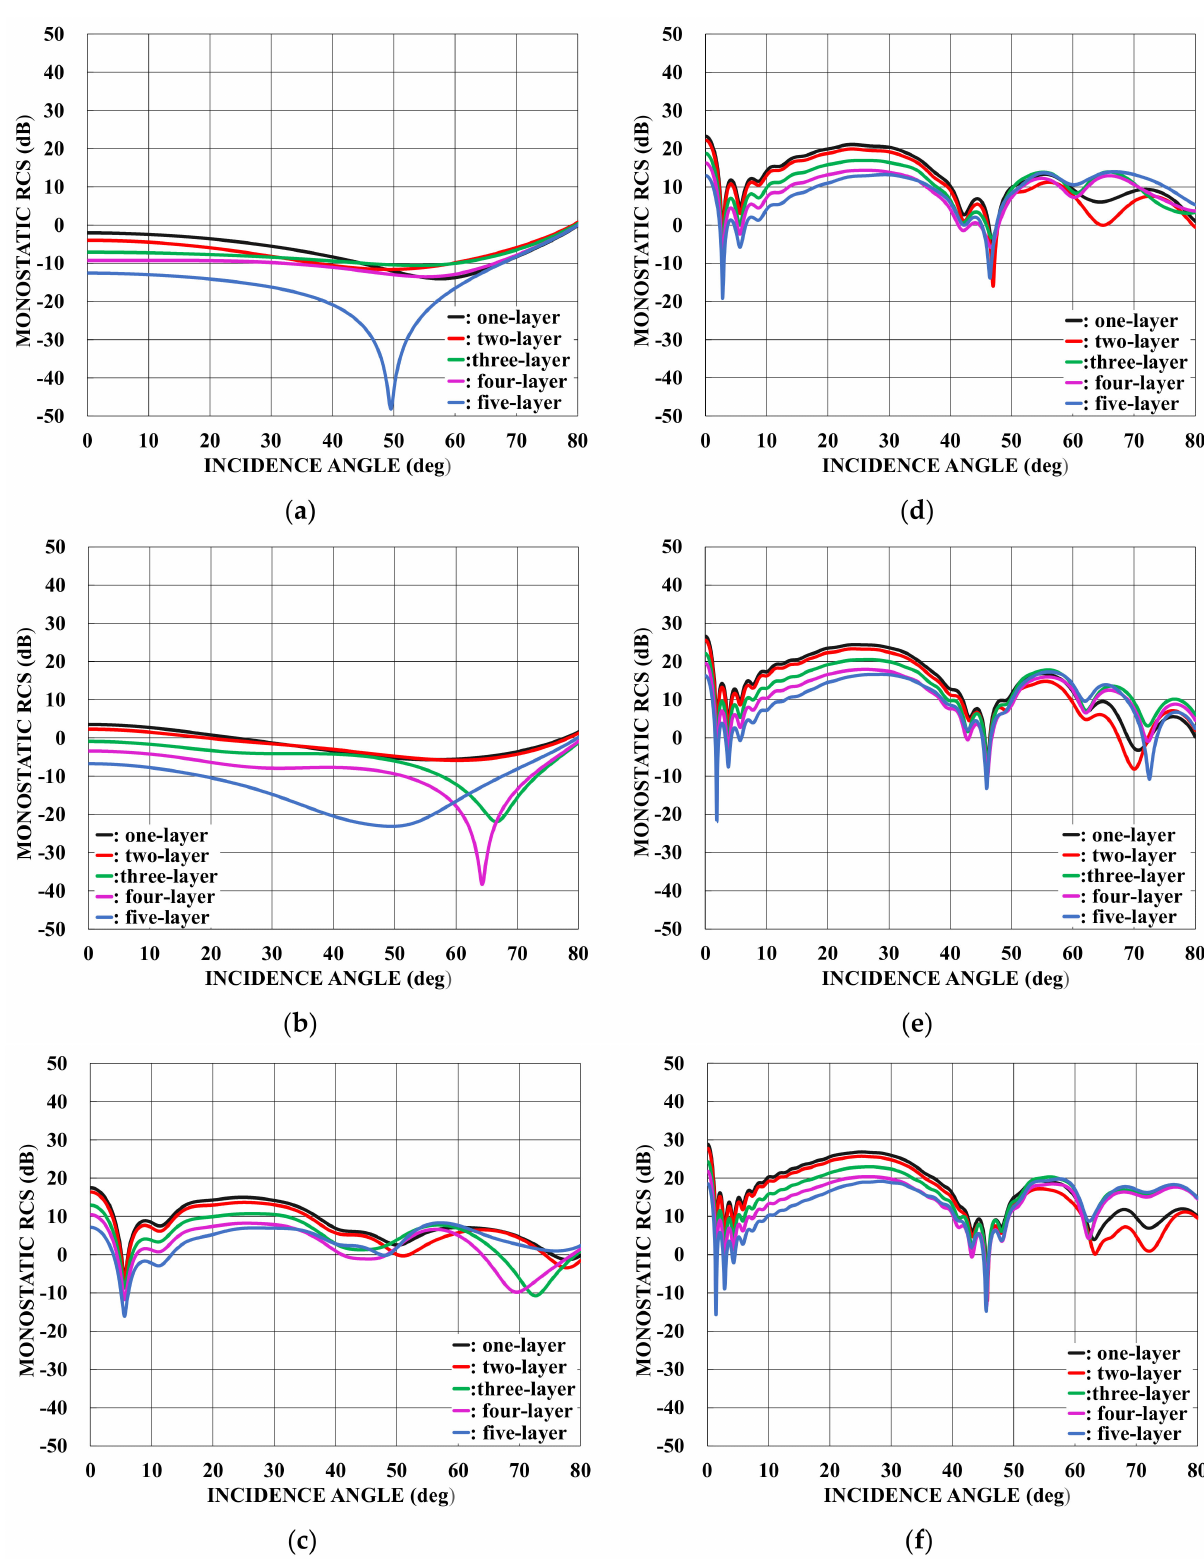
Figure 3. Monostatic RCS [dB] versus incidence angle θ 0 for L 1 /2 b = 1.0, kt = 1.57. Other particulars are the same as in Figure 2. ( a ) kb = 1.57. ( b ) kb = 3.14. ( c ) kb = 15.7.( d ) kb = 31.4. ( e ) kb = 47.1. ( f ) kb =